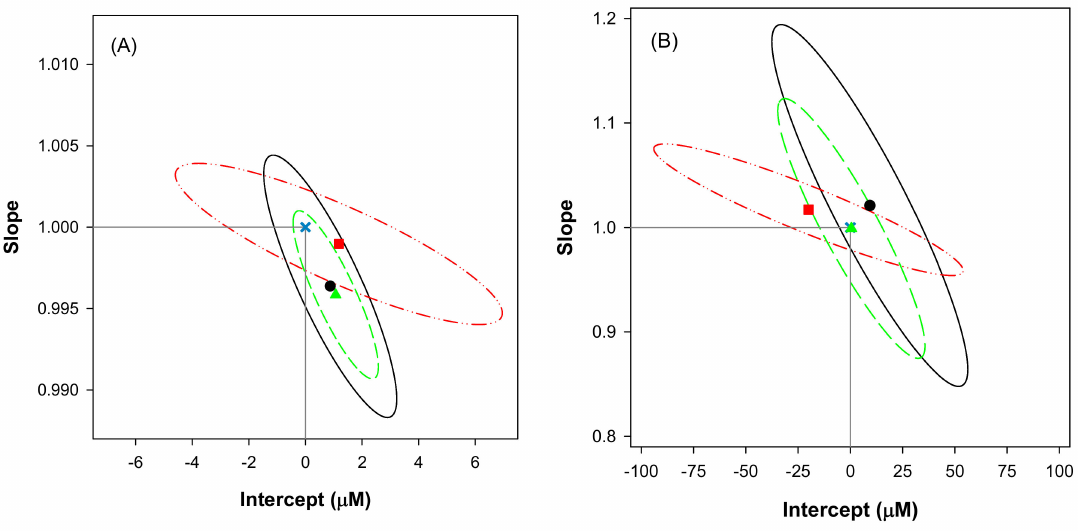
Figure 7. Joint confidence intervals for the three species: ( • , solid line) paracetamol, ( (cid:4) , dash-dotted line) ascorbic acid, and ( (cid:78) , dashed line) uric acid, and both for ( A ) training and ( B ) testing subsets. Also, the ideal point (1,0) is plotted ( x ); intervals are calculated at the 95% confidence